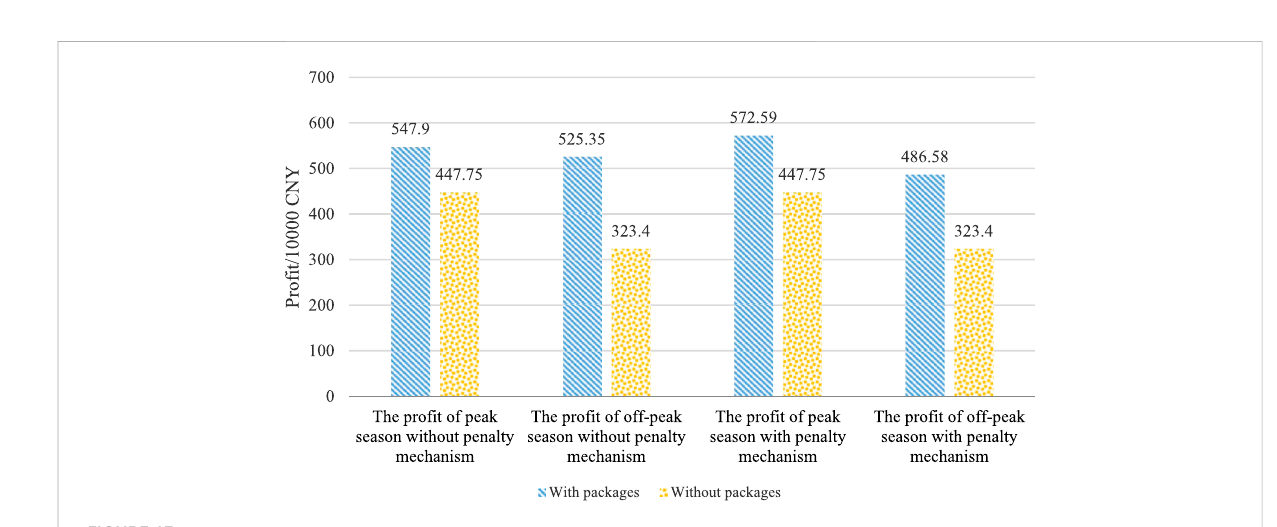
FIGURE 12 Load difference between peak season and off-peak season with and without the penalty mechanism.